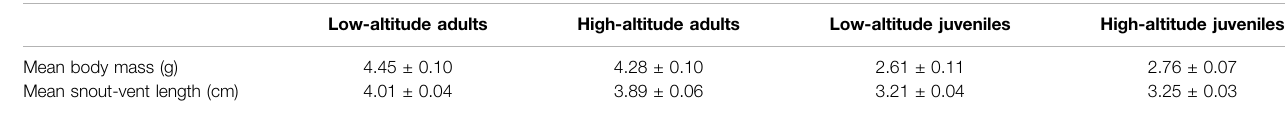
TABLE 1 | Morphometric parameters of N. parkeri adults and juveniles collected from high- and